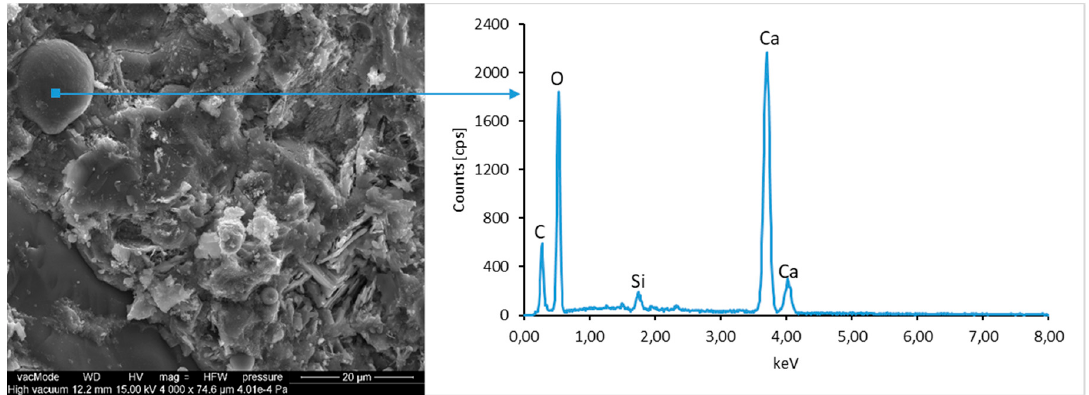
Figure 15. SEM micro-structure of CII.1 concrete and results of elemental analysis in EDS micro-area for visible lamellar portlandite forms forming a rosette embedded in C–S–H phase.